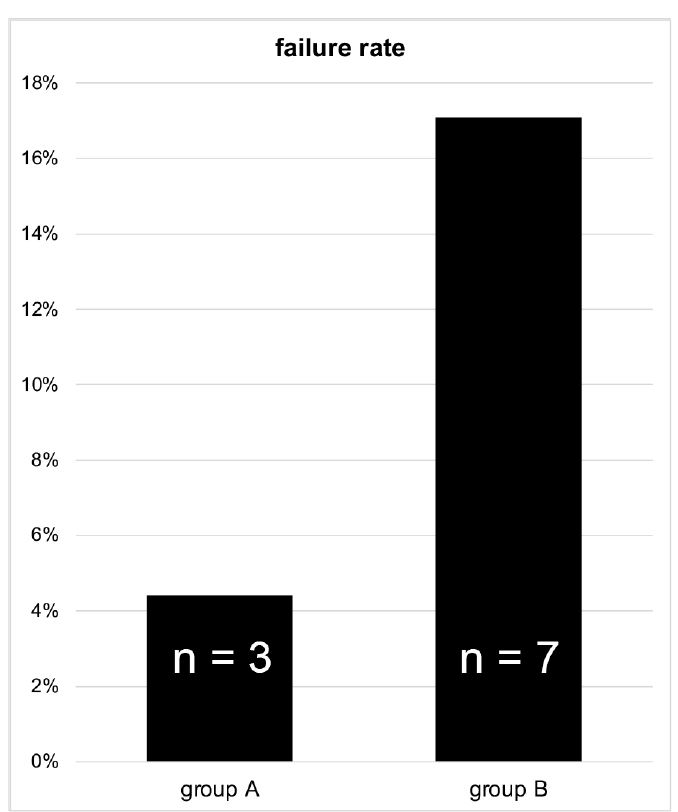
Figure 3. Comparison of the failure rate in surgically treated Garden type III femoral neck fractures.